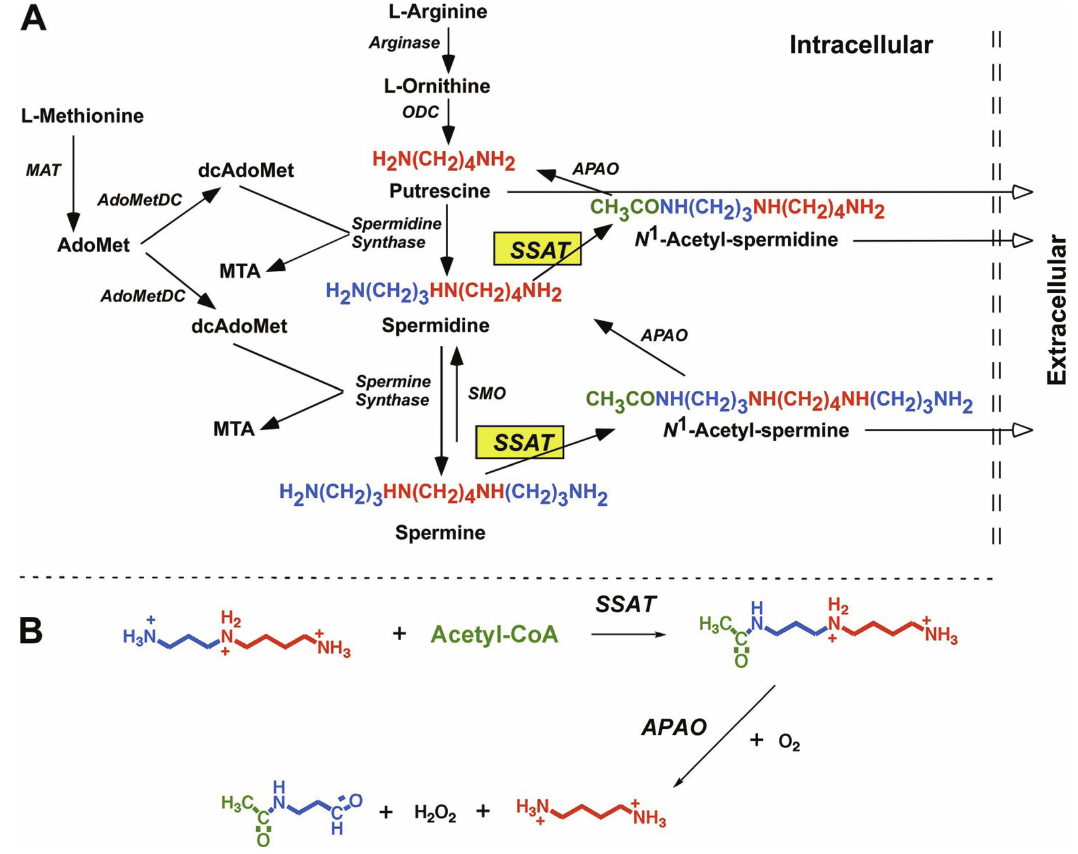
Figure 3 Role of folate through SAM in polyamine metabolism. AdoMetDC, S-adenosylmethionine decarboxylase; APAO, acetylpolyamine oxidase: MAT, methionine adenosyltransferase; MTA,